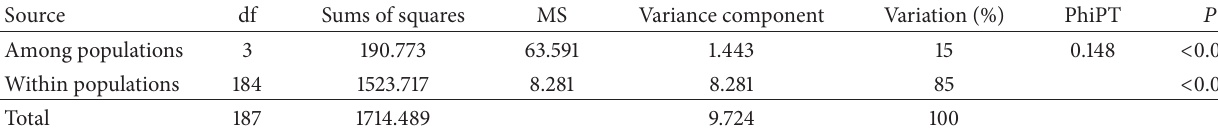
Table 3: The analysis of molecular variance (AMOVA) of natural populations in O. fragrans .